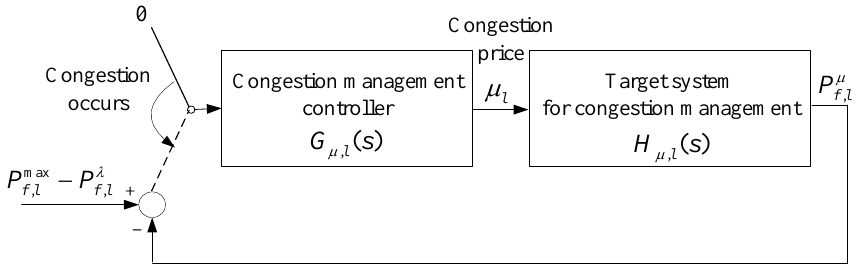
Figure 2. Substructure for the management of line congestion.